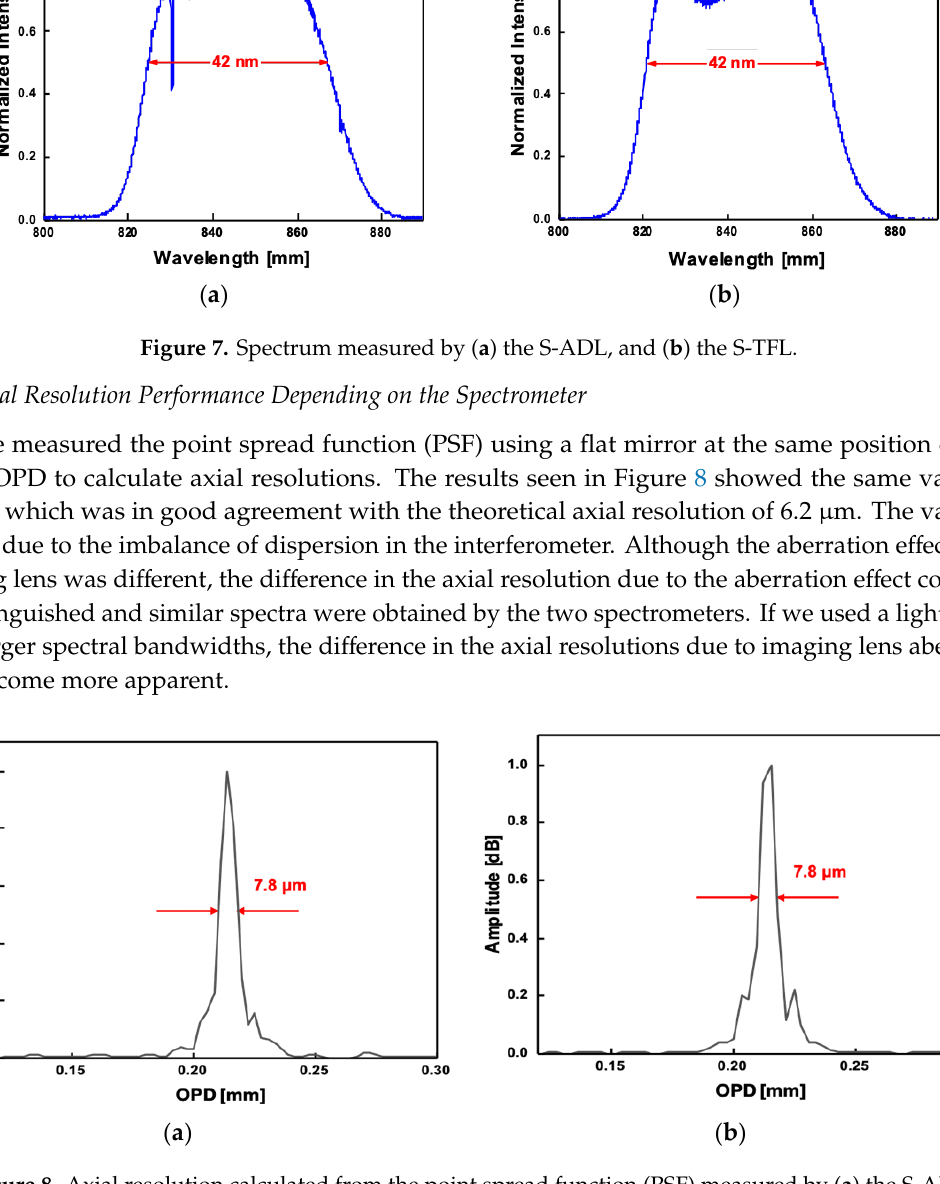
Figure 8. Axial resolution calculated from the point spread function (PSF) measured by ( a ) the S-ADL and ( b ) the S-TFL according to the optical path length difference (OPD).